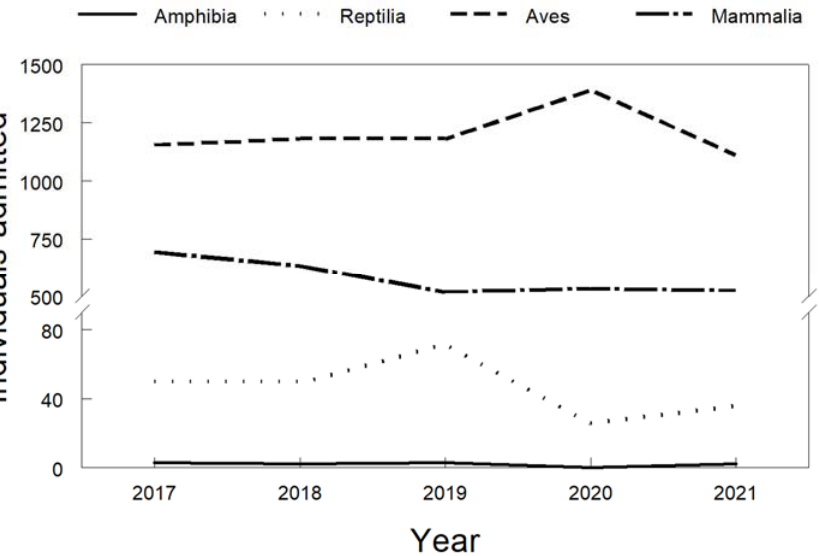
Figure 2. Five-year trends in admittance of amphibians, reptiles, birds, and mammals at the South Plains Wildlife Rehabilitation Center in Lubbock, Texas.